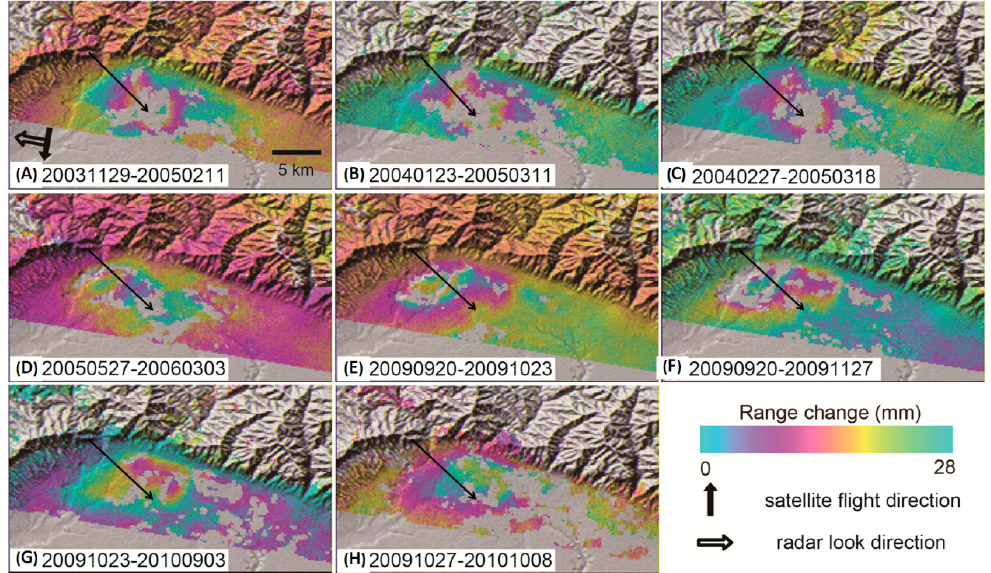
Figure 10. ( A – H ) Interferograms labeled with period (date format is yyyymmdd). The satellite flight direction and radar look direction are labeled in ( A ). Each fringe (full color cycle) represents 28 mm of range change between ground and satellite. Areas that lack interferometric coherence are uncolored.